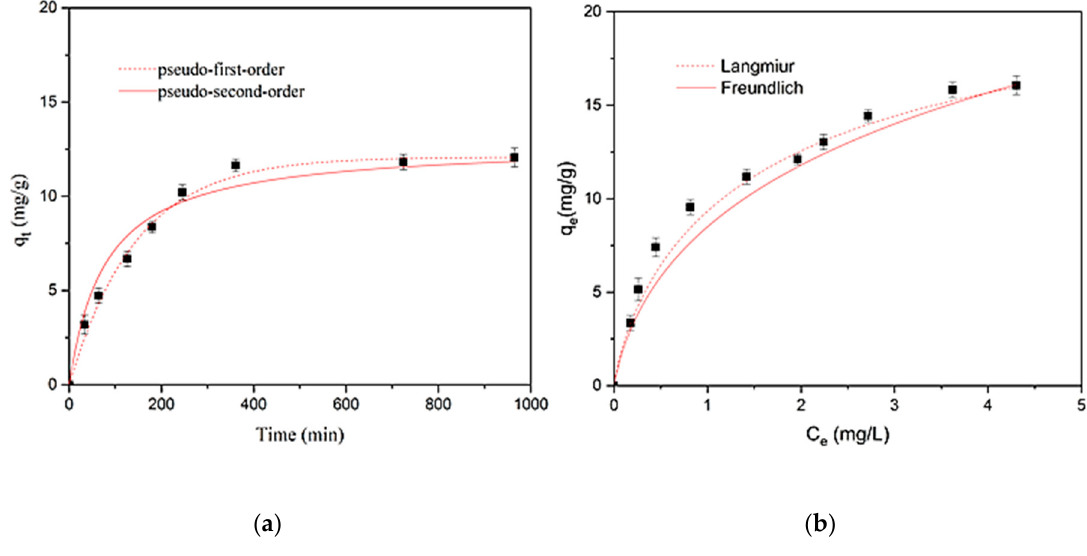
Figure 8. Experimental results together with fittings to the considered models for the adsorption kinetics ( a ) and adsorption equilibrium isotherm ( b ) of SMX onto MY@MIPs in sewage treatment plant (STP) effluent. Table 5. Kinetic and equilibrium parameters corresponding to the adsorption of SMX onto MY@MIPs from the STP e ffl